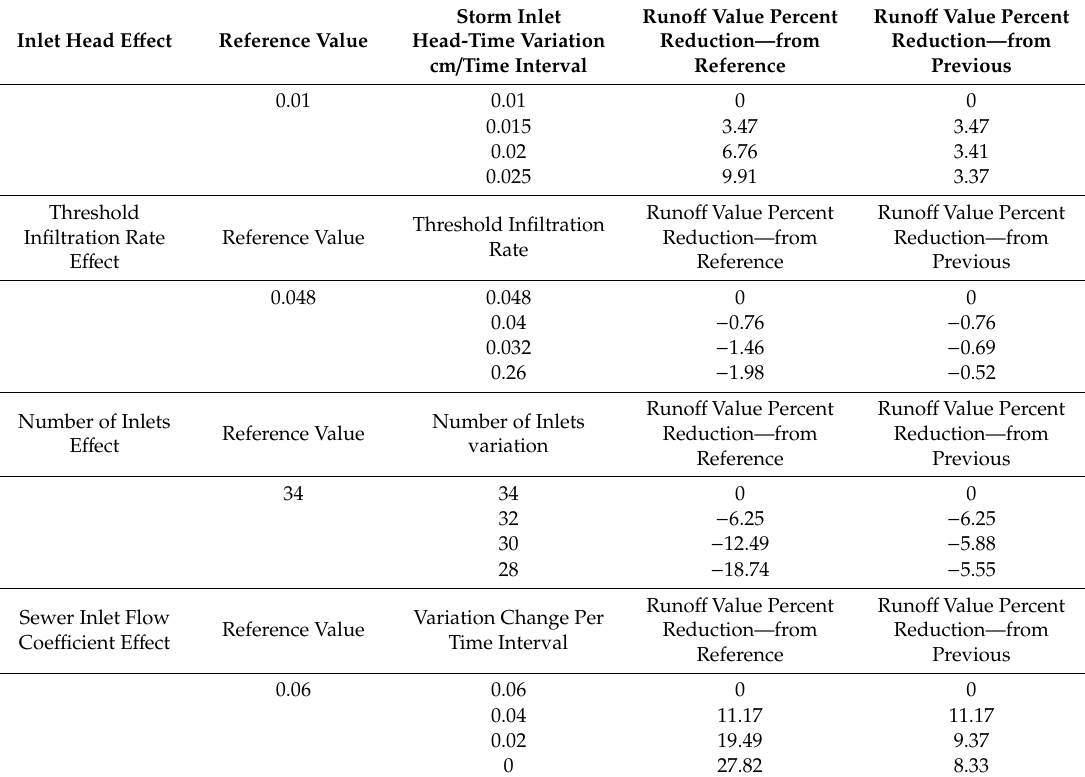
Table 3. Runo ff volume reduction as